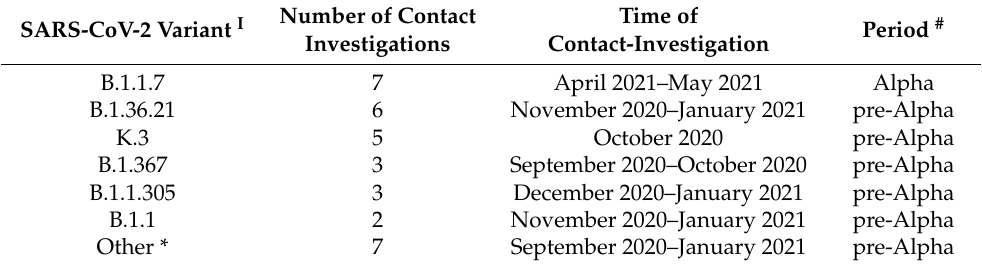
Table 3. SARS-CoV-2 Pango lineage variants among child index cases (n, 33), Oslo and Viken,